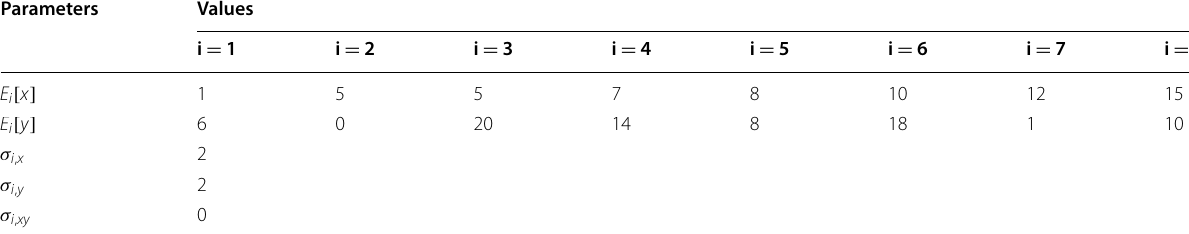
Table 2 The parameters of the gaussian distributions Parameters